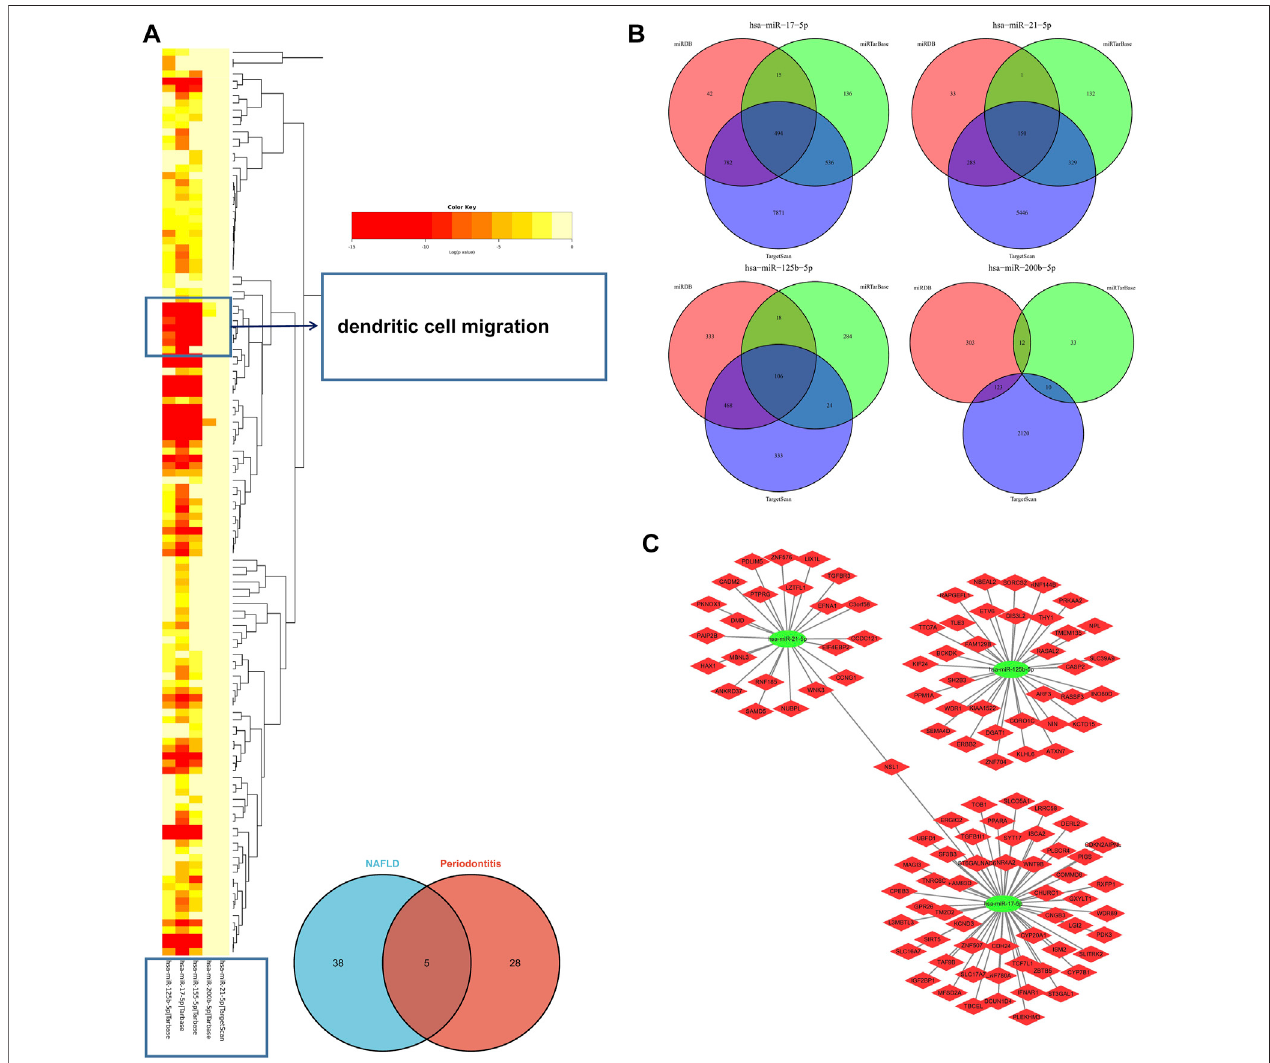
FIGURE 6 | (A) The functional enrichment analysis of fi ve common miRNAs. The arrow indicated the dendritic cell migration signaling pathway. (B) The Venn diagram of predicted target genes of miRNAs according to miRTarbase, miRDB, and Targetscan databases. (C) MiRNAs – mRNAs network. MiRNAs, microRNAs.